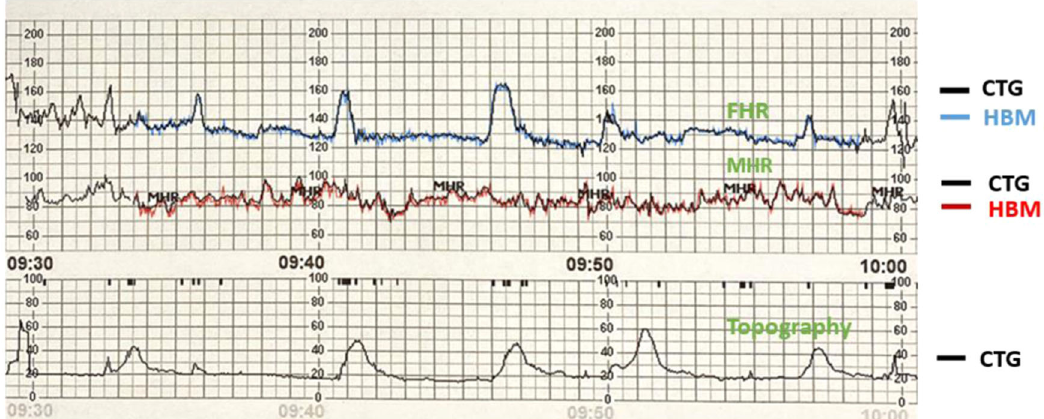
Fig. 7 Superposition of fetal and maternal heartrate recordings collected by cardiotocography and fetal heartbeat monitor. FHR Fetal Heat rate, MHR Maternal heart rate, CTG